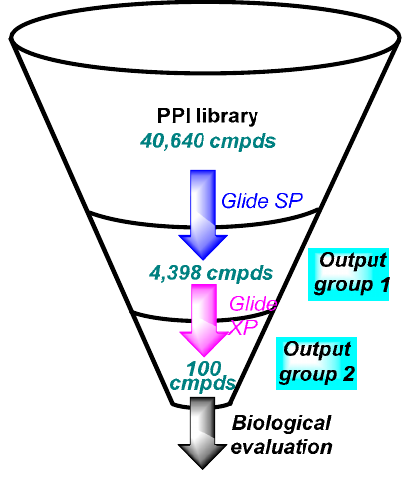
Figure 3. Virtual screening workflow using a PPI library.